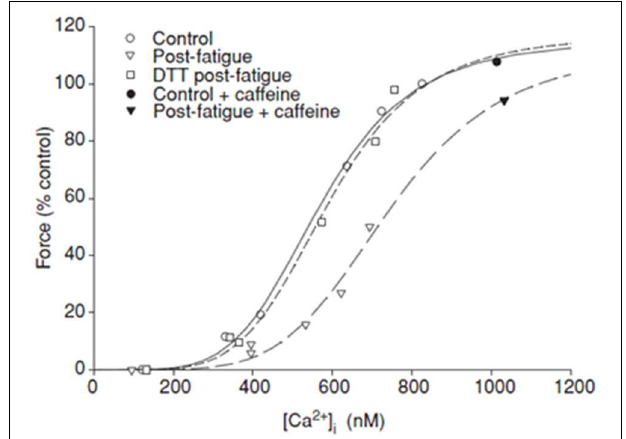
FIGURE 2 | ROS mediated fatigue and Ca ++ -sensitivity. Force-calcium relation plotted during fatigue of intact mouse flexor brevis muscle fibers stimulated at 100Hz, at 37 ◦ C. Force expressed relative to rested value under control conditions. Fatigue under control conditions produced a strong rightward shift in the relation and depressed maximal force. Maximal force but not Ca ++ -sensitivity was restored with caffeine. Treatment with dithiothreitol (DTT) restored Ca ++ -sensitivity. Reprinted from Moopanar and Allen (2006) with permission from John Wiley and Sons publishing company.